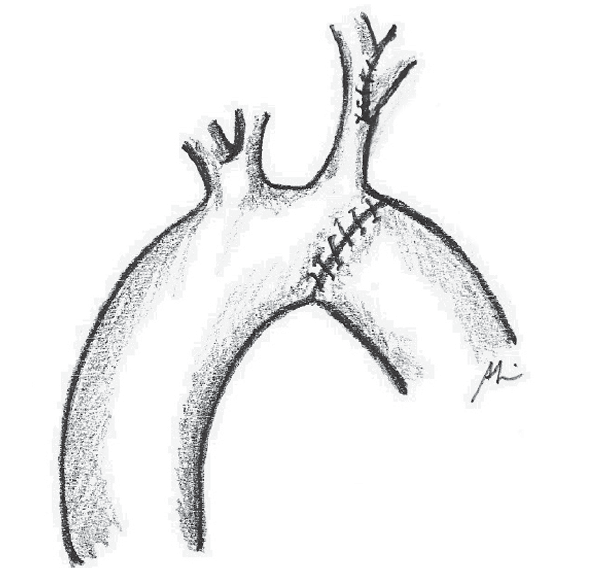
Fig. 8 - Reimplante da artéria subclávia em látero-terminal sobre a artéria carótida esquerda